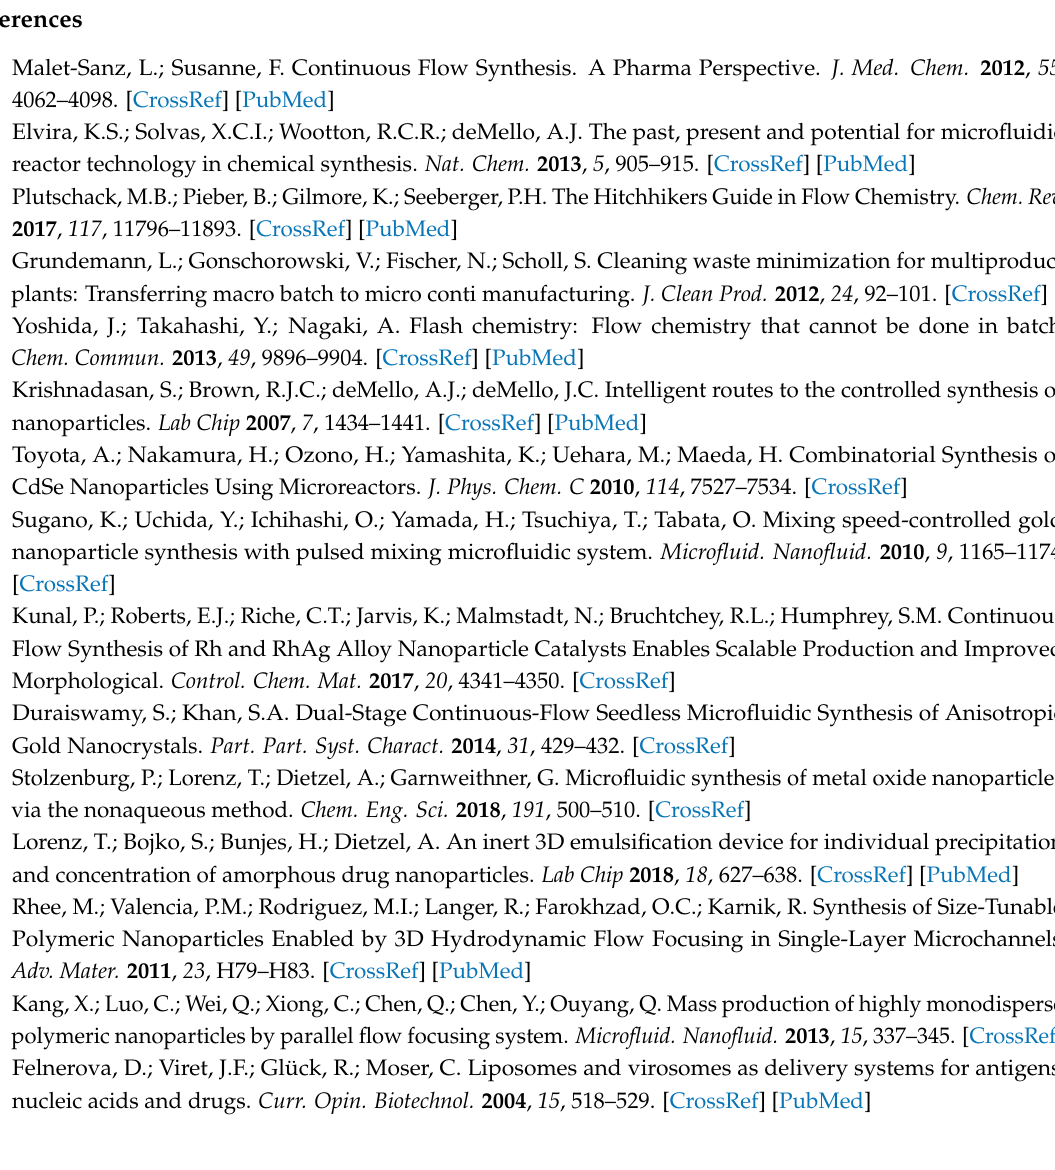
Figure A3. Cross section of channels used in the detection chip.